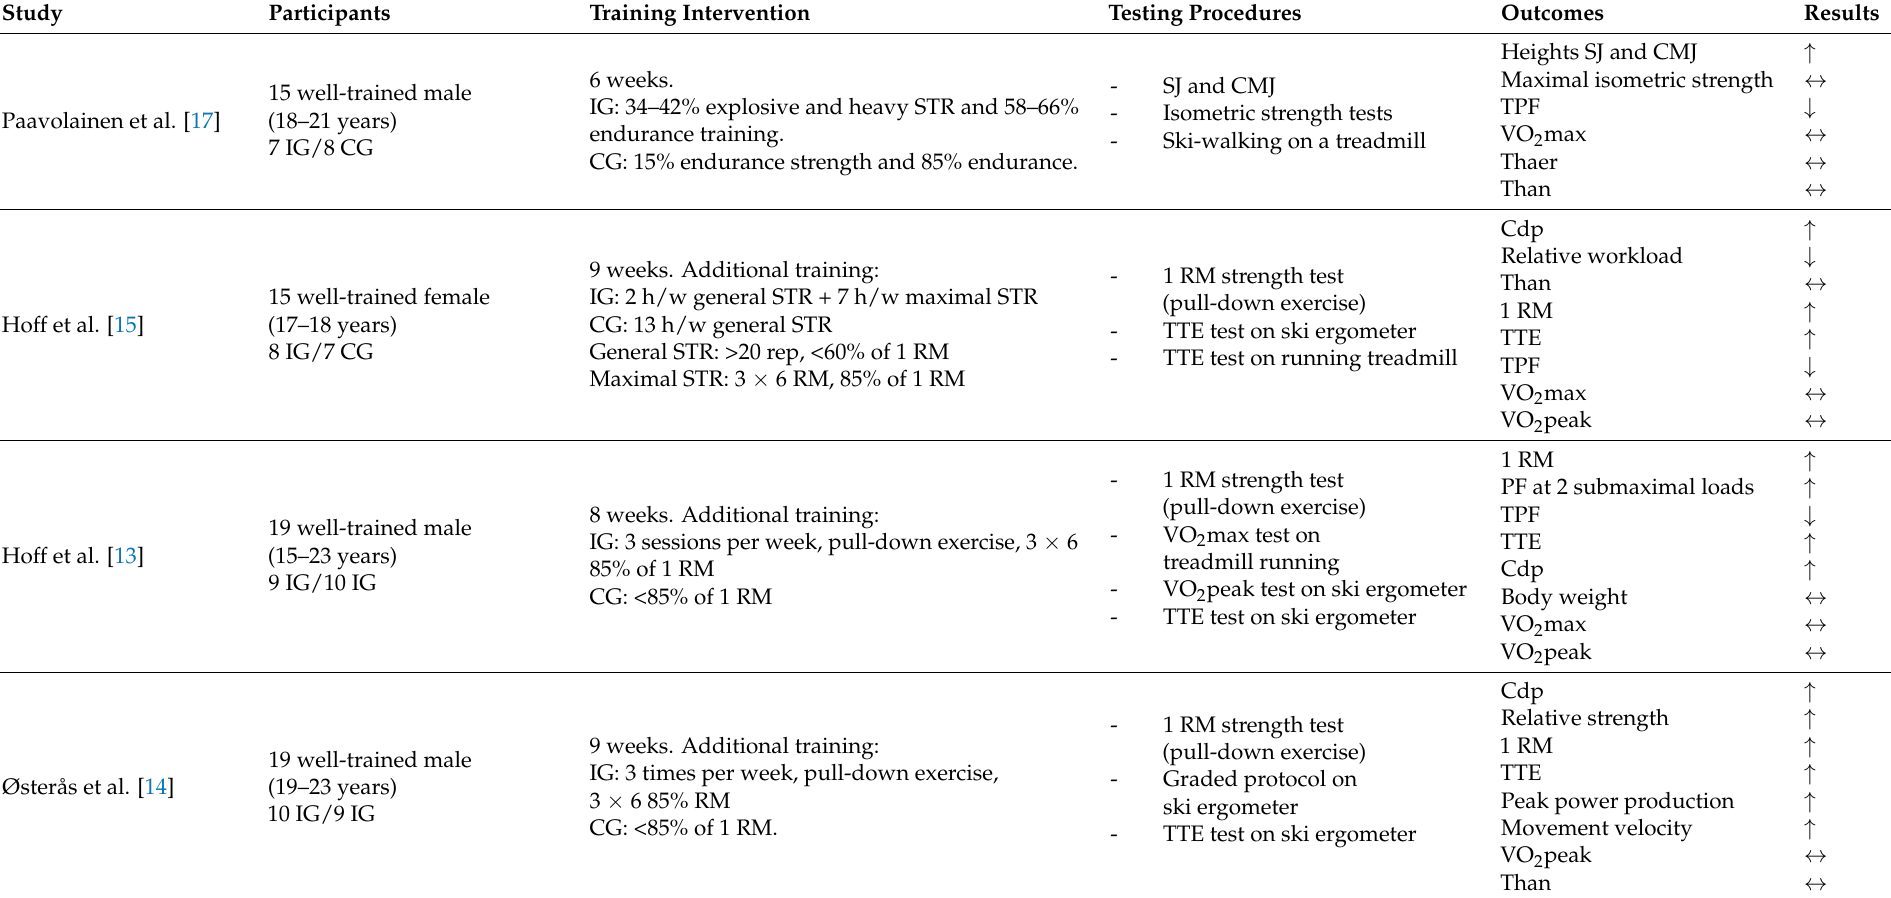
Table 2. Characteristics of studies included in